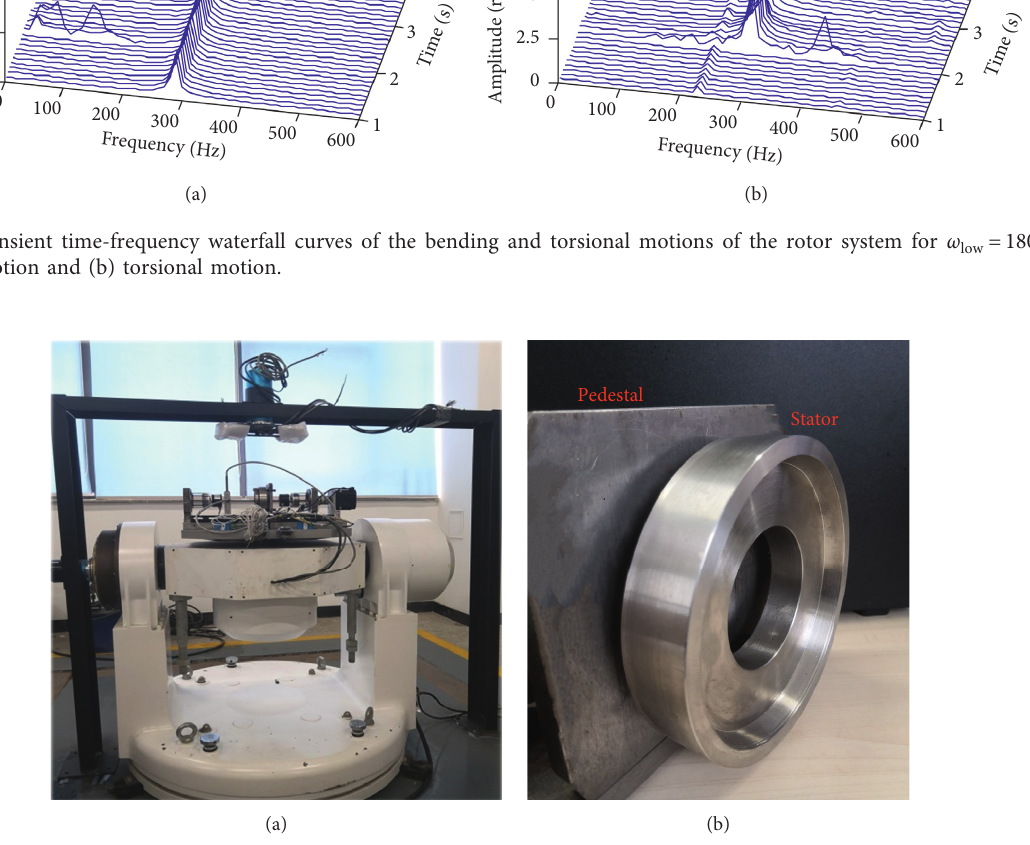
Figure 17: Main experimental devices and rub-impact device. (a) Main experimental devices and (b) rub-impact device.